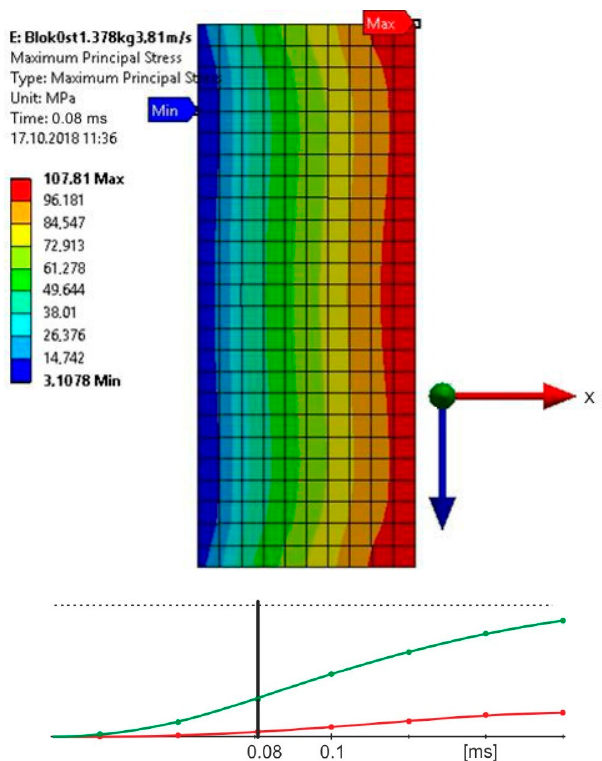
Figure 7. Maximum principal stress distribution for the computing time of 0.08 ms, in the joint loaded with the energy of 10 J, at a speed of 3.81 m/s .